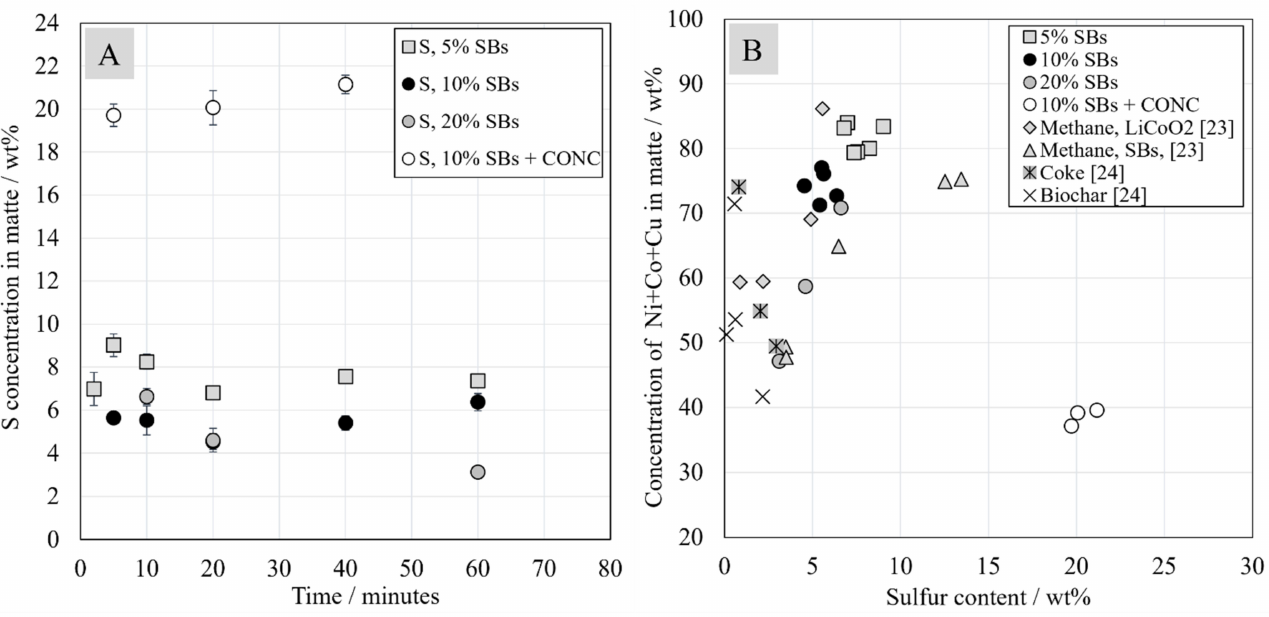
Figure 7. Sulfur concentration in matte ( A ) and total concentration of nickel, cobalt, and copper in the matte ( B ) as a function of sulfur concentration in the